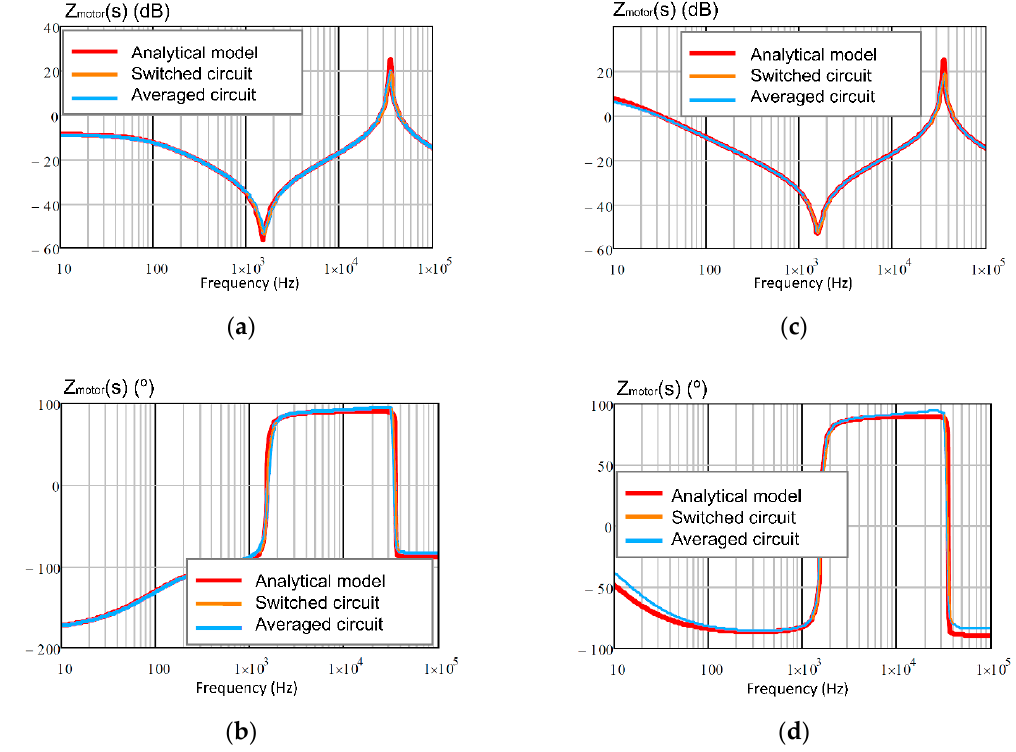
Figure 25. Frequency response of the small-signal input impedance, Z motor (s) , of the motor drive-electric motor-vehicle system in both motor mode, ( a ) gain and ( b ) phase; and generator mode, ( c ) gain and ( d ) phase.